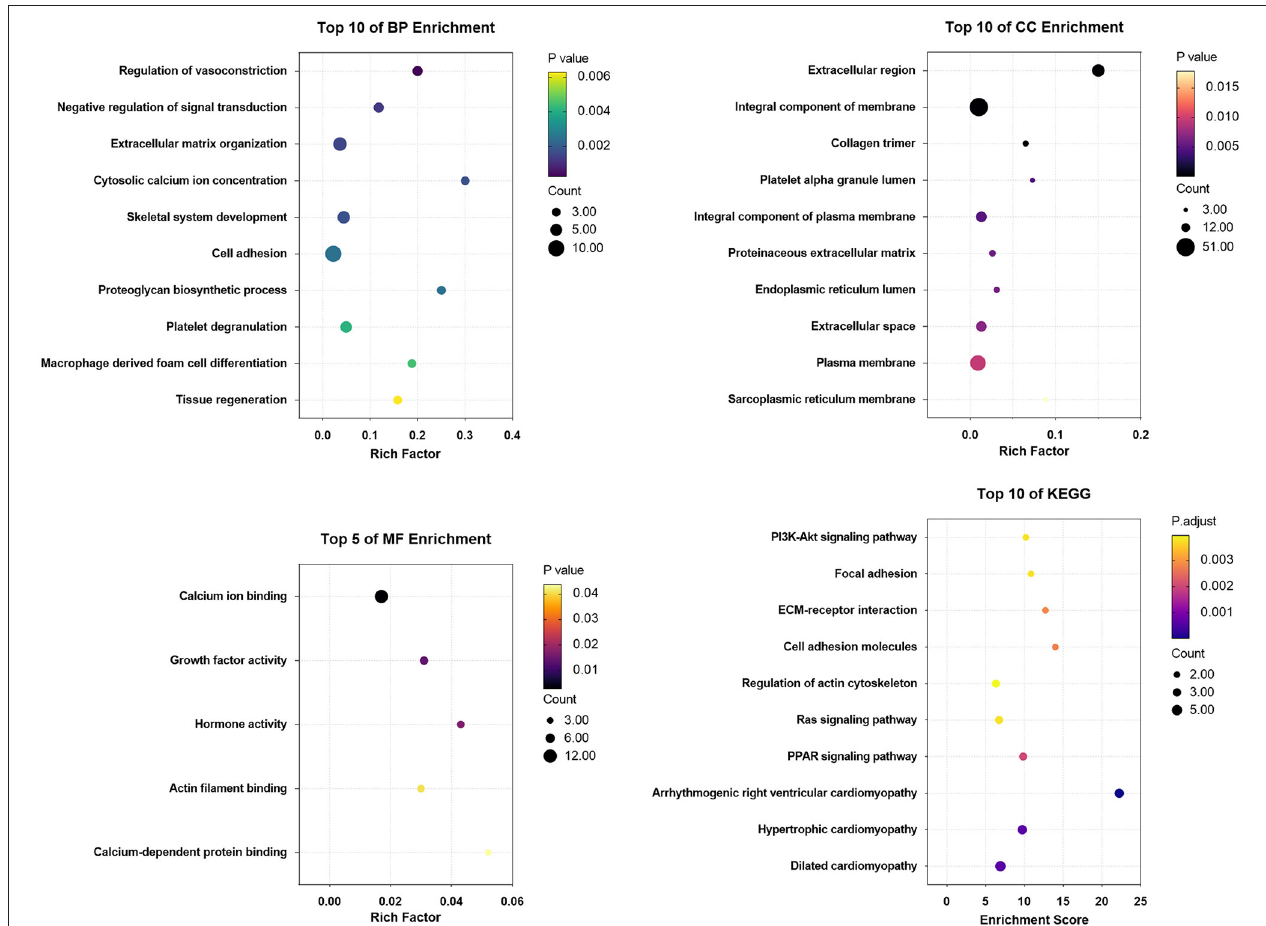
FIGURE 8 | The enrichment analysis of DEGs in Ang II vs. CFs by DAVID and Metascape. Detailed information relating to changes in the CC, BP, MF, and KEGG analysis for hub genes is